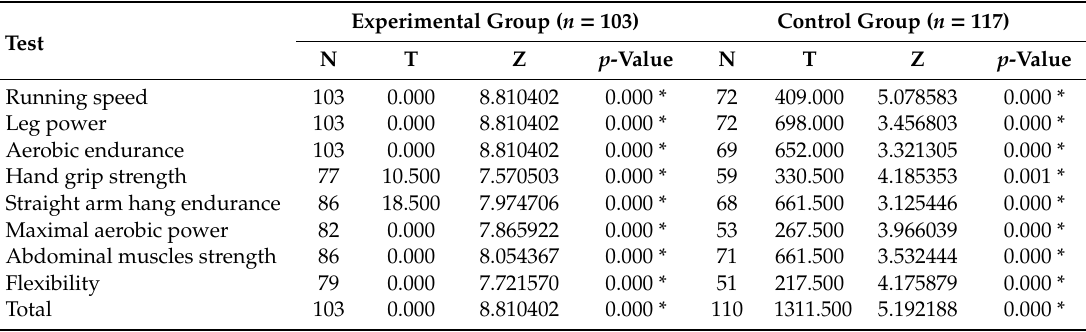
Table 1. Comparison of physical fitness of the students in the experimental group in the initial and final measurement and the control group in the initial and final measurement. The T score formula enables to take an individual score and transform it into a standardized form, one which helps to compare scores. Z value refers to a standardized score, also known as a z-score.